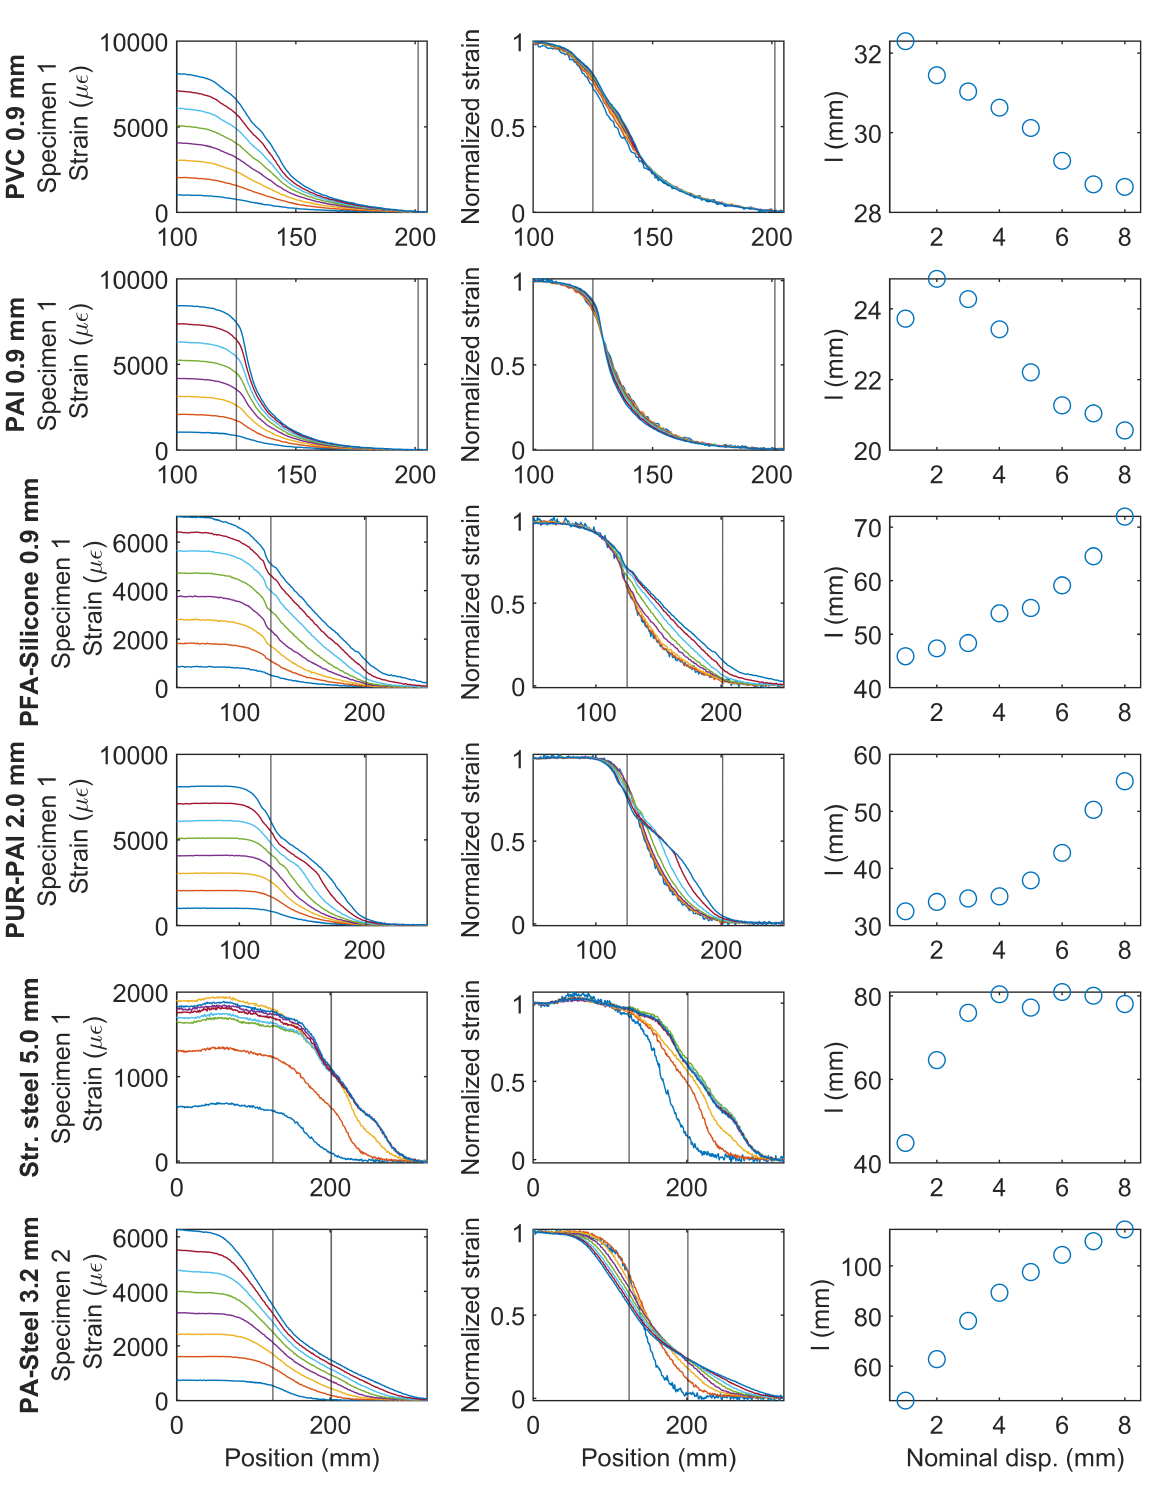
Figure 19. Sample strain distributions for each type of cable and smoothing parameters l (different color lines represent strain distributions under increasing displacement levels).